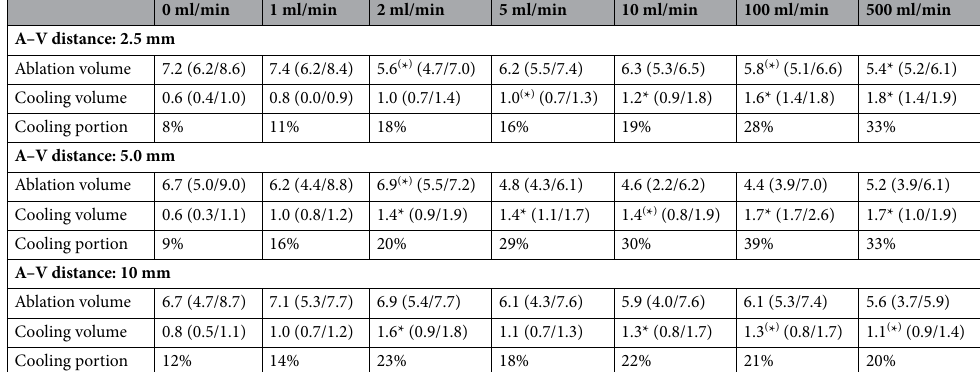
Table 1. Ablation volume and cooling volume (ml) depending on the vascular flow rate. The cooling volume was derived by subtracting the achieved ablation volume from an idealized ablation defined by the respective maximum radii of each ablation slice. The test series with perfusion were compared to the test series without perfusion (median (min/max); *p ≤ 0.008; ( * ) p = 0.008–0.05).